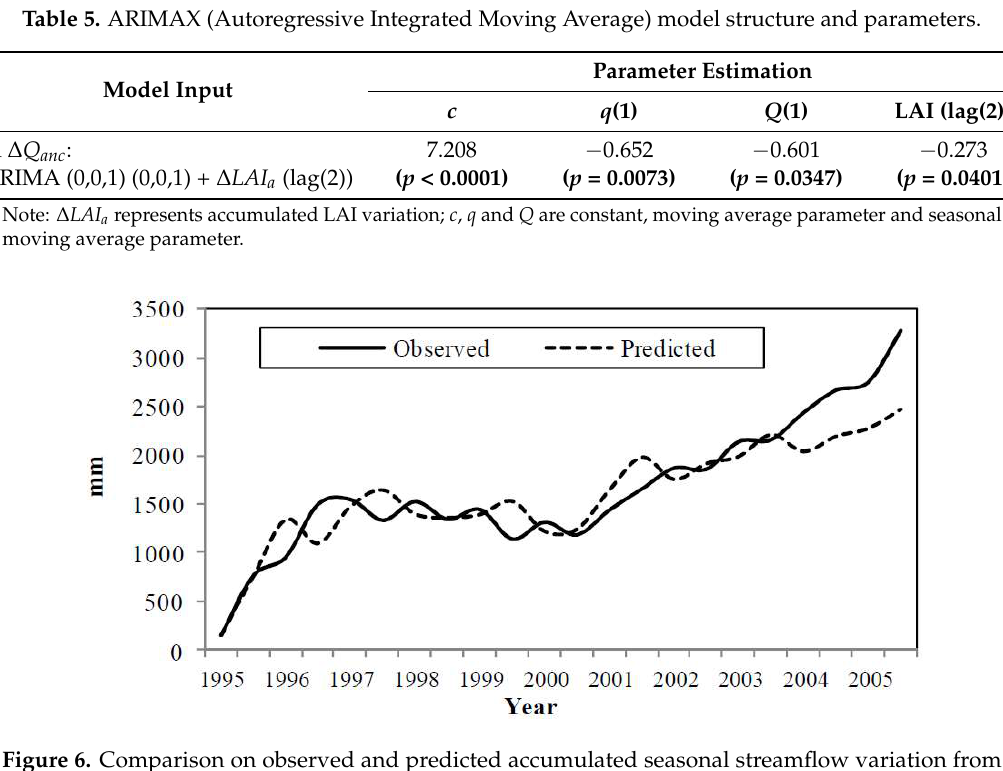
Figure 6. Comparison on observed and predicted accumulated seasonal streamflow variation from non-climate factors.